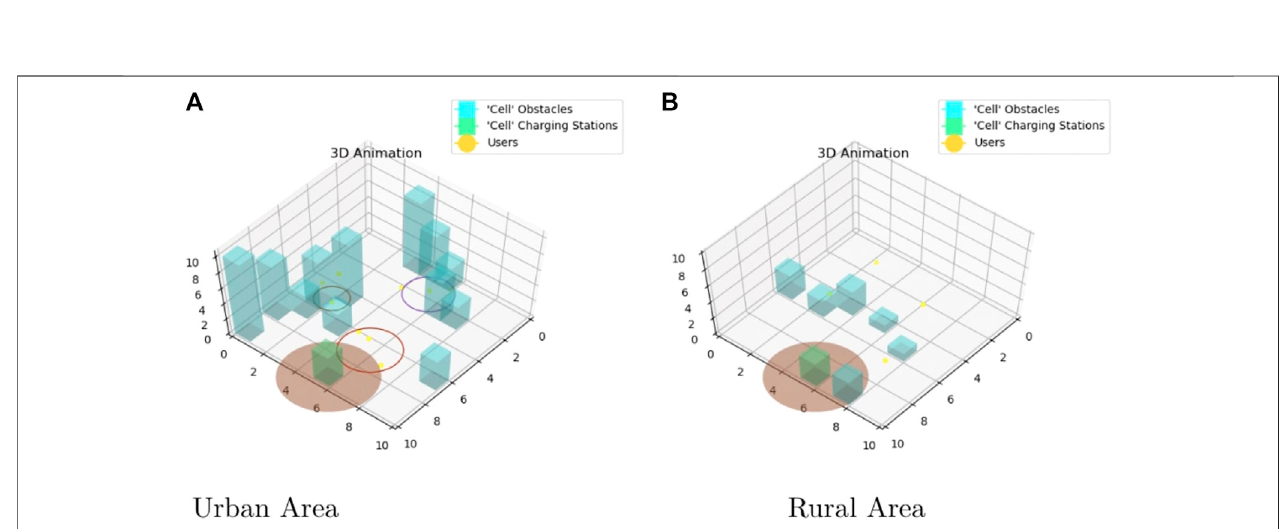
FIGURE 1 | An urban area where multiple UAVs operate to serve some AR and IoT users asking for service; some charging stations are placed in the considered area.